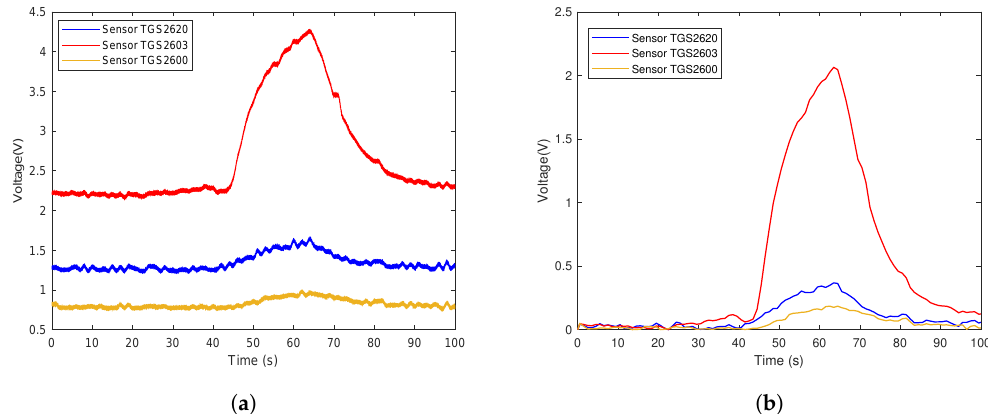
Figure 11. Time series of rotten meat odor raw data and the data after preprocessing in the second experiment. ( a ) Shows the representative example of the time series of the original response curves of the sensor array for the odor from rotten meat. ( b ) Shows results after preprocessing.